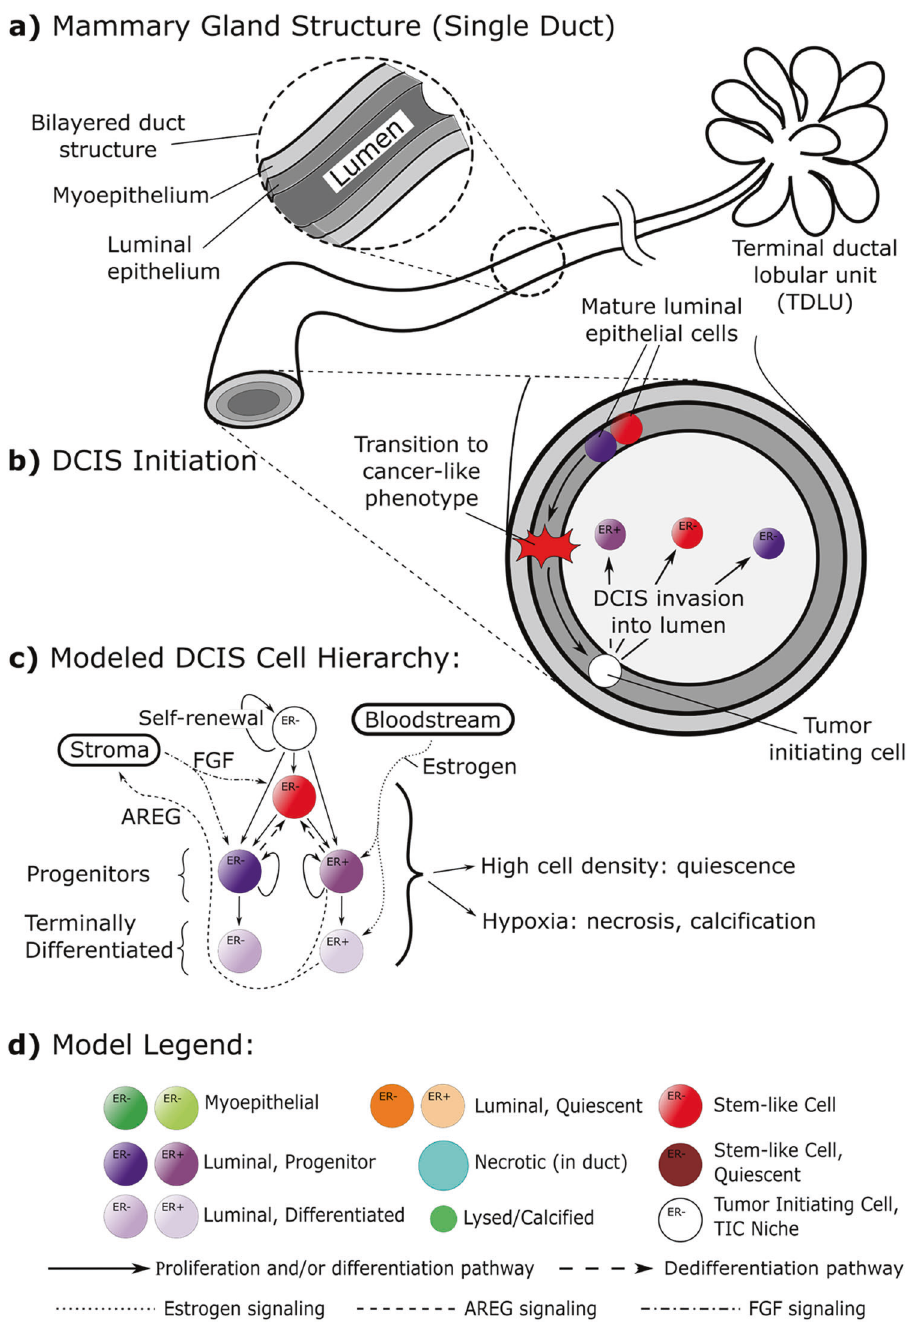
Fig. 1 Model schematic and included biology. a The mammary gland is composed of bilayered epithelial walls surrounding an inner luminal cavity. This tree-like structure branches away from the nipple into the fat pad, and ducts are terminated by ductal lobular units. b The duct wall is composed of outer myoepithelial and inner luminal epithelial cell monolayers. In our model, cancer is initiated by transition of a stem cell within the luminal epithelium into a tumor initiating cell (TIC), which is able to proliferate inde fi nitely, placing its daughters adjacently into the luminal cavity. c Mammary epithelial cells are phenotypically distinct cells and are characterized based on their proliferative potential and the presence or absence of estrogen receptor α (ER + / − , respectively). Proliferation within the DCIS population is regulated by simpli fi ed endocrine and paracrine pathways, as shown. d Model